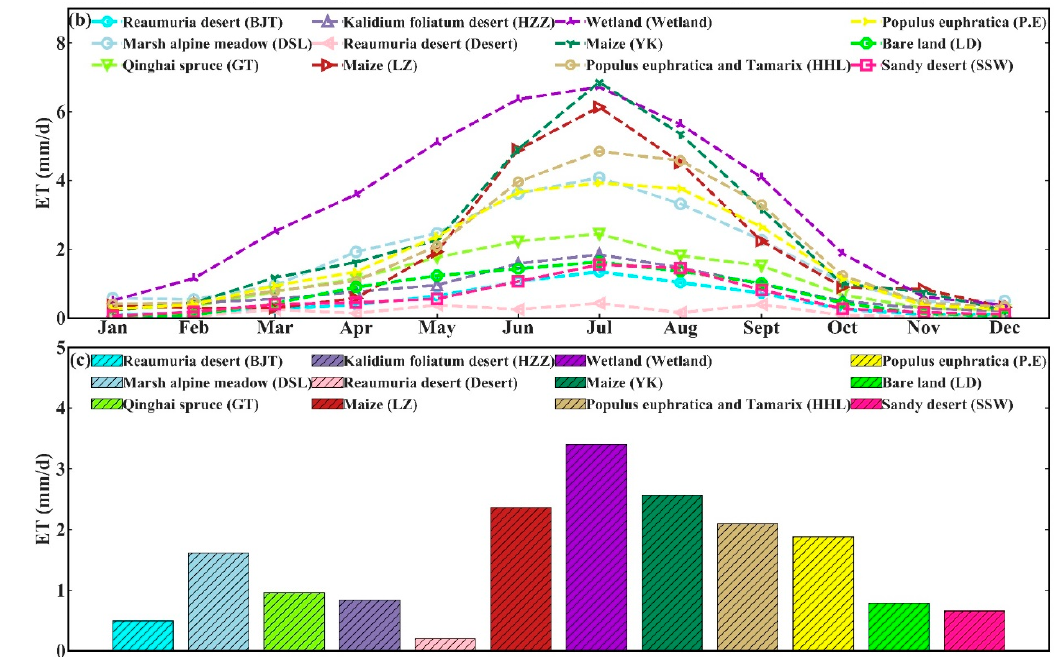
Figure 12. The statistics of the ground truth ET at the pixel scale over twelve surface types in the HRB during the period from 2010 to 2016. ( a ) Daily variation, ( b ) monthly average daily value, and ( c ) multiyear average daily